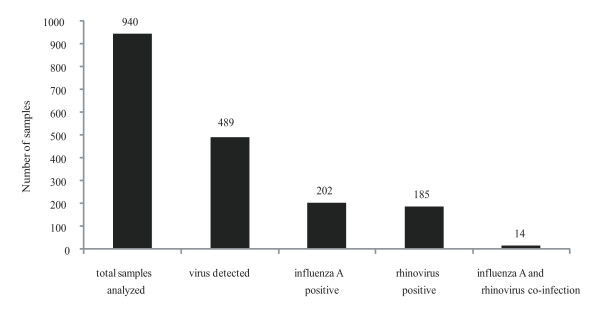
Summary of virus infections and co-infections with influenza A virus and human rhinovirus.